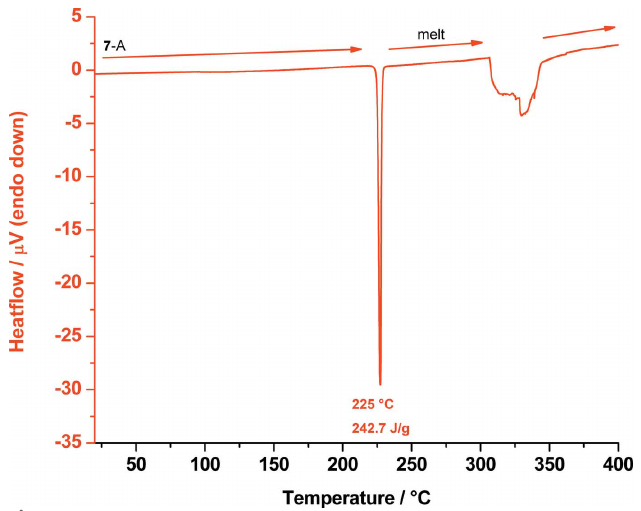
Figure 17 DSC trace of myo -inositol ( 7 ) measured from 20 up to 400 (cid:2) C showing its melting point of polymorph 7 -A at 225 (cid:2) C and its decomposition between 306 and 363 (cid:2) C.